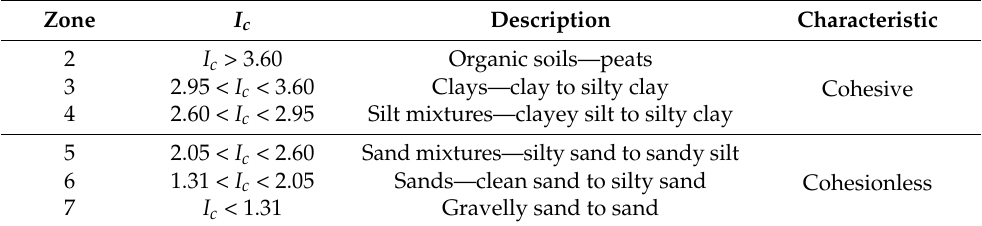
Table 1. Soil classification of